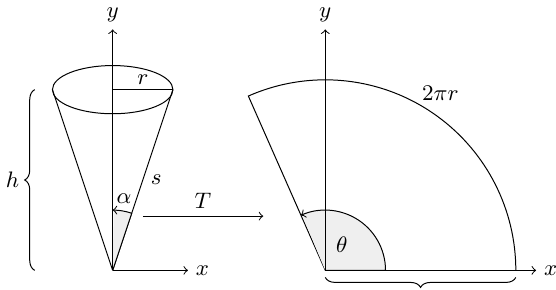
Figure 5: An unwrapped version of an approximately conical ves- sel, UMJ Inv.-No. 4611 (Karl et al., 2009), that has been rotated to convey the depth information. The highlighted contour is the cross-section at the splitting meridian. This line is identical to the profile line as drawn by archæologists (Orton et al.,